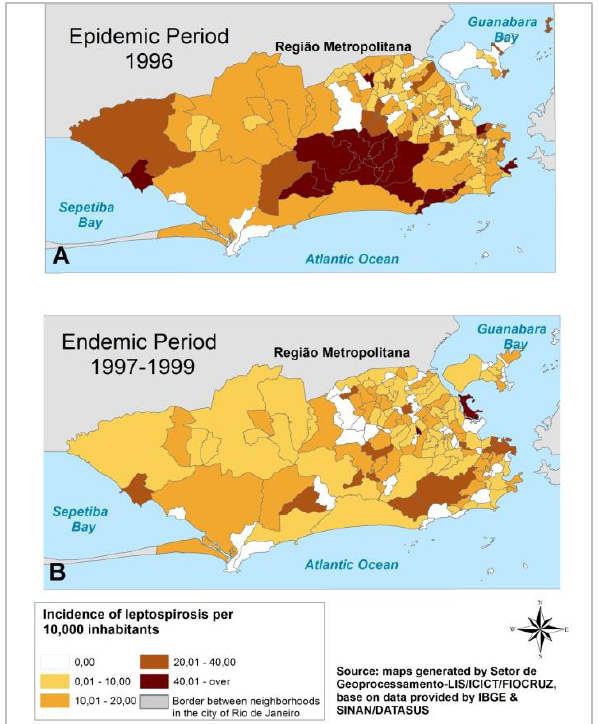
Figure 2. Leptospirosis incidence rates in the neighborhoods of Rio de Janeiro city during epidemic ( A ) and ( B ) endemic periods,